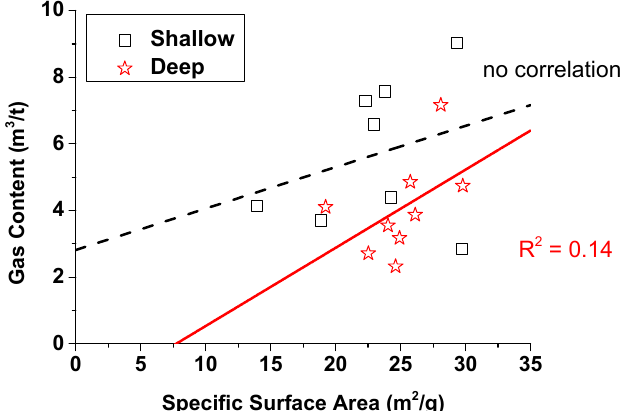
Figure 6. Relationship between gas content and specific surface area.